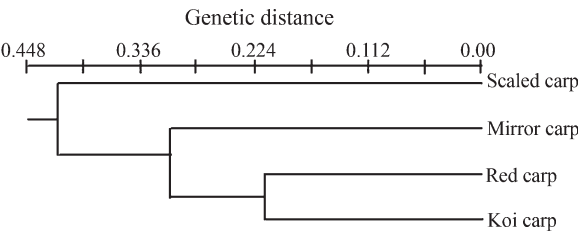
Figure 1 - Unweighted pair-group method with averages dendrogram based on Nei’s (1972) genetic distance, summarizing the data on differen- tiation between C . carpio strains, according to microsatellite DNA analy-